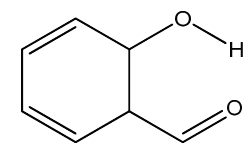
Figure 6. Example of a molecule transformed from salicylaldehyde but with a single bond between the acceptor and the